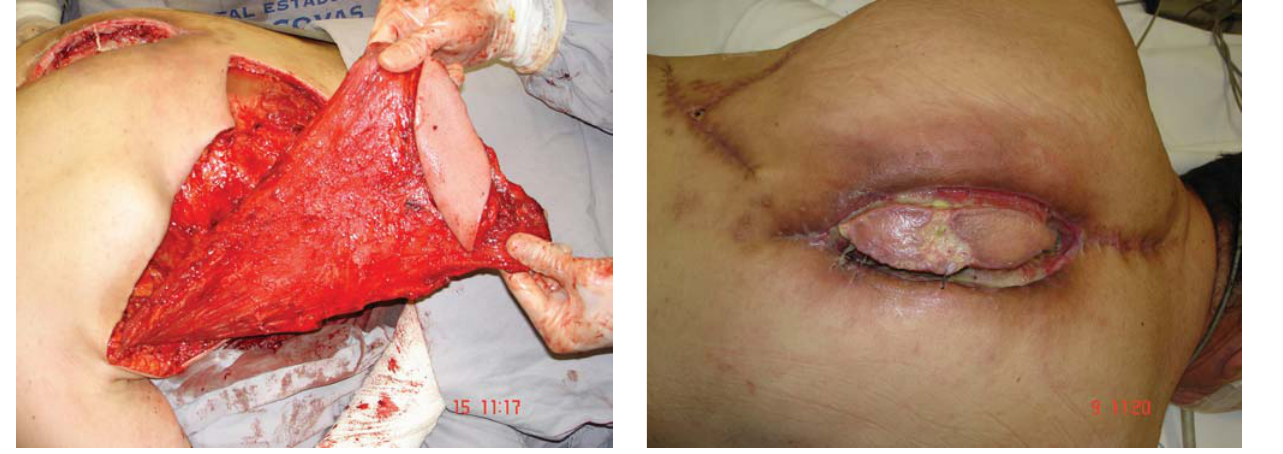
Figure 4 - Partial necrosis of the distal tip of the flap with consequent retrac- tion and partial re-exposure of the implant